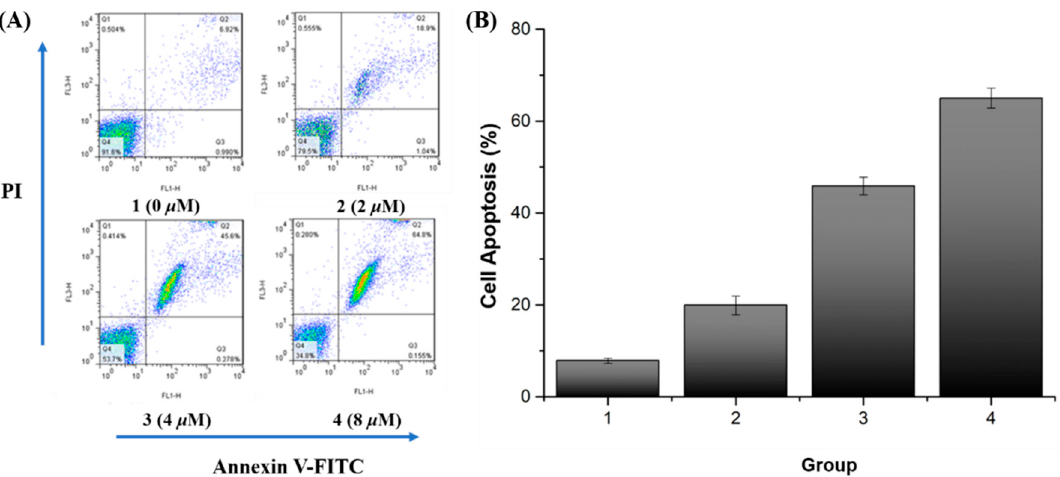
Figure 3. ( A ) Compound 4b induced apoptosis in SW620 cells with the density of 0 µ M, 2.0 µ M, 4.0 µ M, and 8.0 µ M. SW620 cells were treated with for 24 h. Values represent the mean ± SD, n = 3, p < 0.05 versus control. The percentage of cells in each part was indicated. ( B ) apoptosis histogram of SW620 induced by compound 4b .